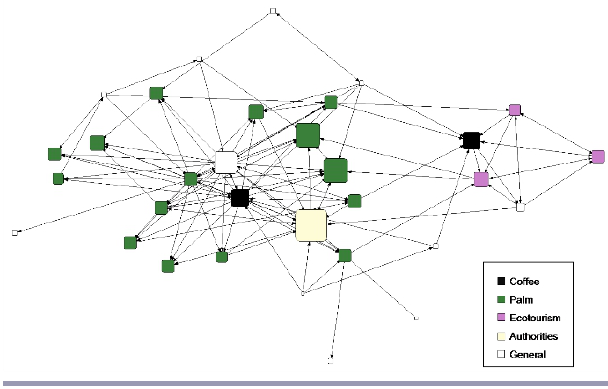
Fig. 3 . Sociogram of individuals assigned to the network with the highest indegree. Node size is proportional to indegree.